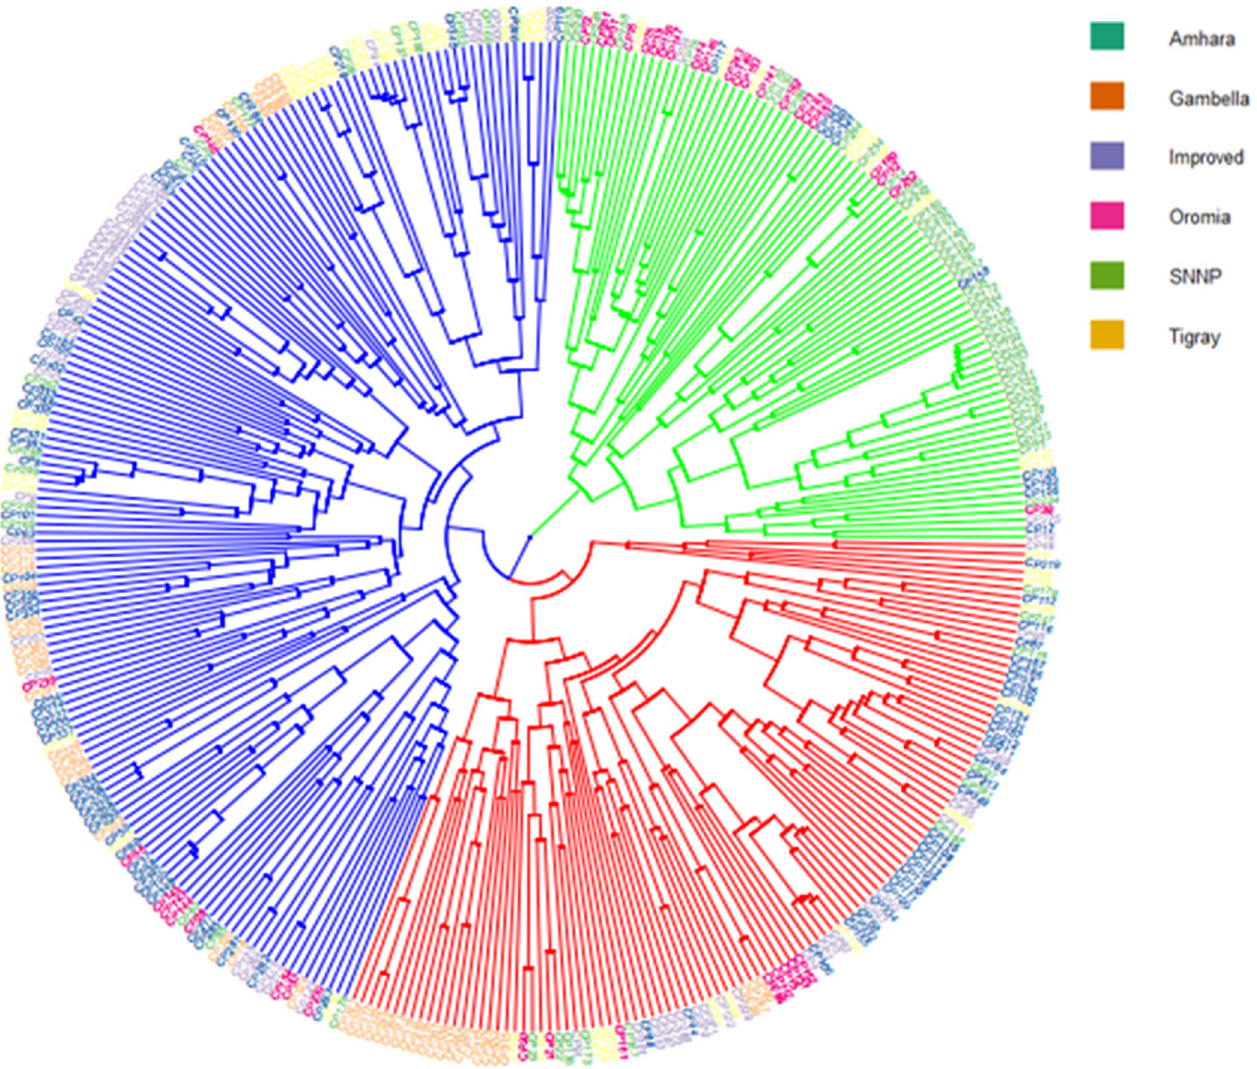
Fig 2. UPGMA dendrogram showing the genetic relationships among cowpea collections grouped into three distinct clusters (cluster 1 = red, cluster 2 = green and cluster 3 =